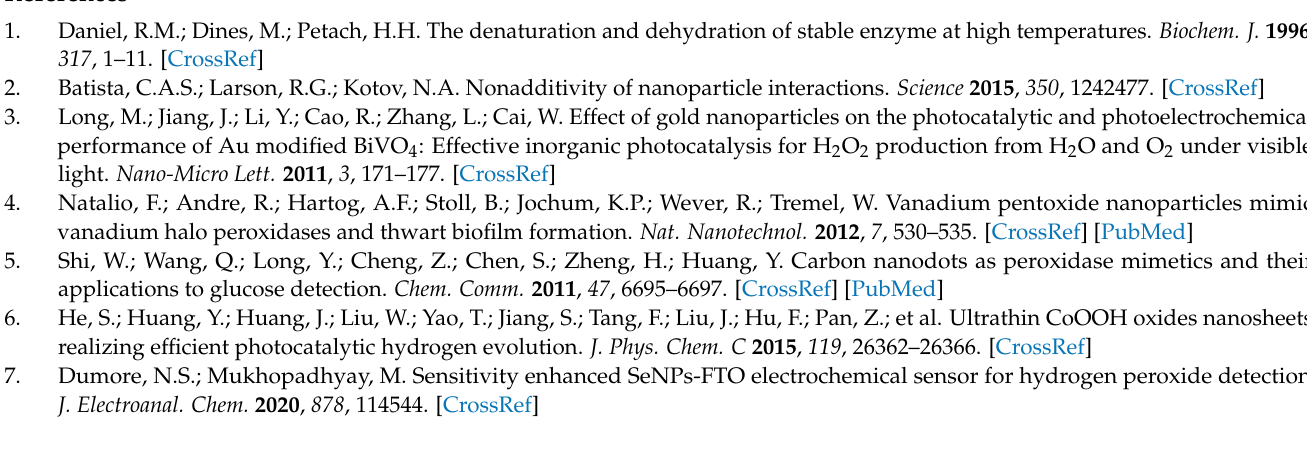
Table S2. Variables, level of design experiments, and Box-Behnken Design (for catechol and res- orcinol); Figure S1: FT-IR spectra of H-1, H-2, H-3 and H-4 NPs; Figure S2: SEM EDS of (a) H-1 NPs (b) H-2 NPs (c) H-3 NC; Figure S3: TEM of (a) H-1 NPs (b) H-2 NPs; Figure S4: Comparison of activity of different samples; Scheme 1. Mechanism of PPO activity using resorcinol; Figure S5: Plot of initial rates versus substrate concentration of oxidation catalysed by H-4 nanocomposite (a) Catechol (b) Resorcinol; Figure S6: The lineweaver burk plot for H-4 NC (a) Catechol (b) Resorcinol; Table S3: Kinetic parameters for PPO-like activity mention in text discuss; Table S4: Analyses of variance for quadratic model of catechol; Table S5. Analysis of variance for quadratic model of resorcinol; Figure S7: (a) Correlation between the experiments with predicted values of enzyme activity (using catechol), (b) Normal probability plot of residuals obtained by ANOVA for the enzyme activity of H-4 nanocomposite (using catechol); Figure S8: Correlation between the experiments with predicted values of enzyme activity (using resorcinol), (b) Normal probability plot of residuals obtained by ANOVA for the enzyme activity of H-4 nanocomposite (using resorcinol); Figure S9: The linear caliberation plots for (a) catechol detection b) resorcinol detection; Figure S10: Caliberation plot of total phenolic content determined by the MgFe 2 O 4 @Mn 3 O 4 nanocomposite based